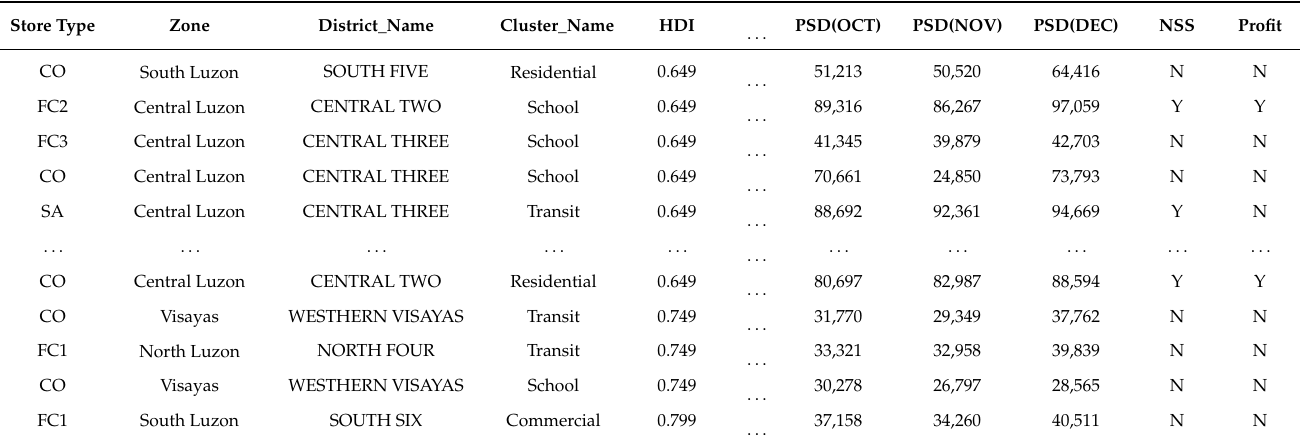
Table 2. Some date set (original source of data).